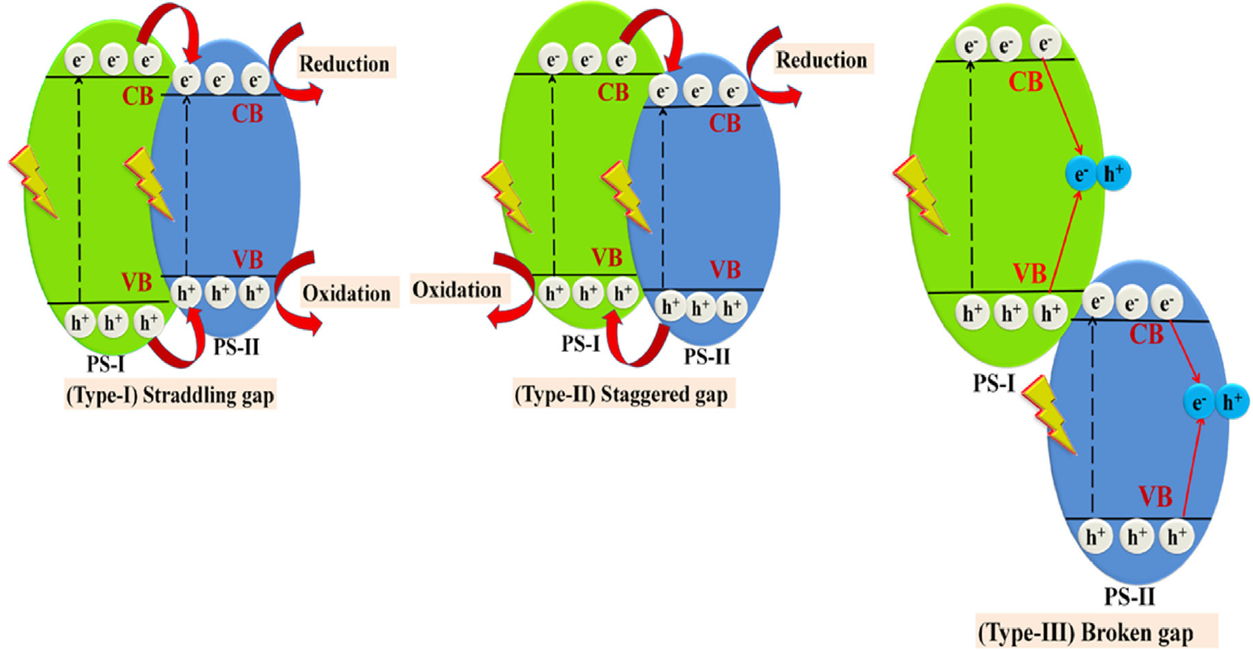
Figure 14. Schematic heterojunction growth of type-I straddling gap, type-II staggered gap and type-III broken gap. Reprinted from [167] with the permission of Elsevier.